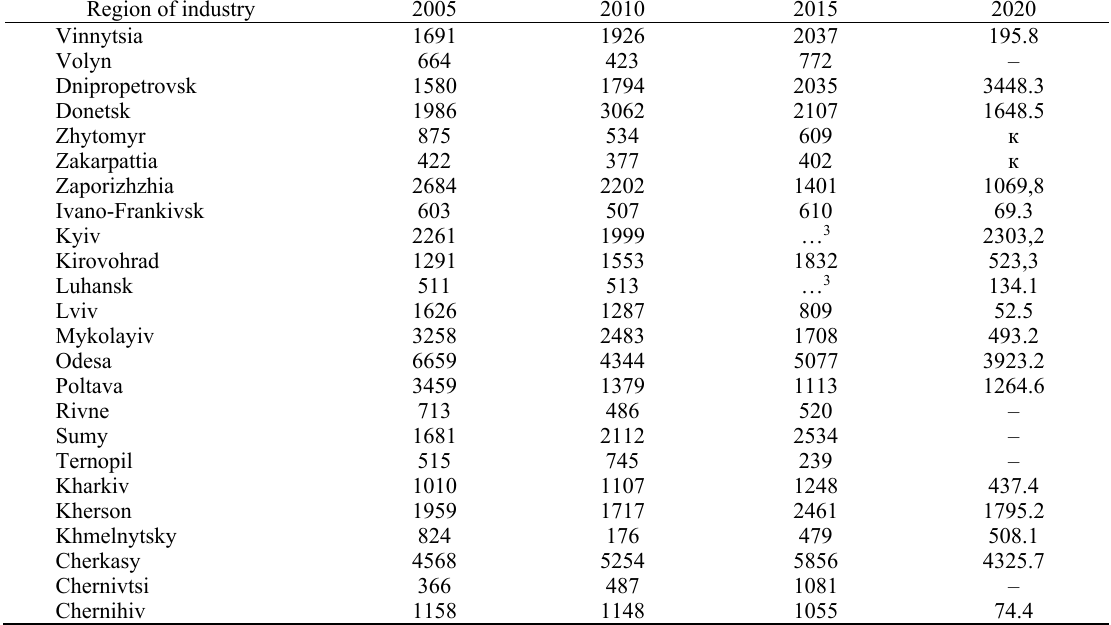
Catch of aquatic organisms in inland waters by fishing regions 2005–2020, tons (According to the State Statistics of Ukraine) (Derzhavna sluzhba statistiki Ukrayini)